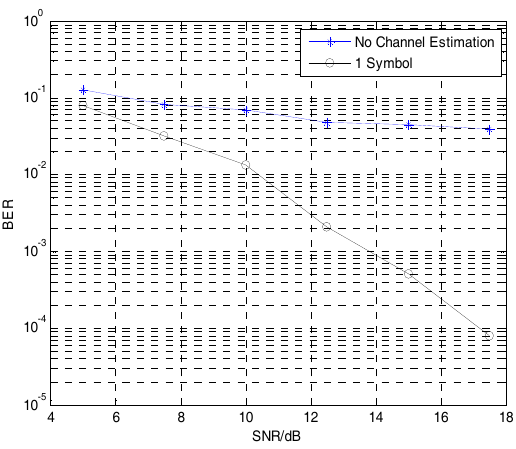
Figure 4. Performance of channel estimation based on the LS method with one symbol.